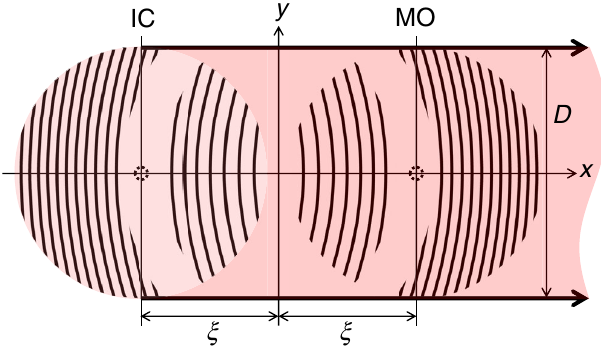
FIG. 2. Grating lines of a 3D-2D-3D optics imaging system with an input coupler (IC) and a mologram (MO). Only every 50th line is shown, together with some adjacent lines.